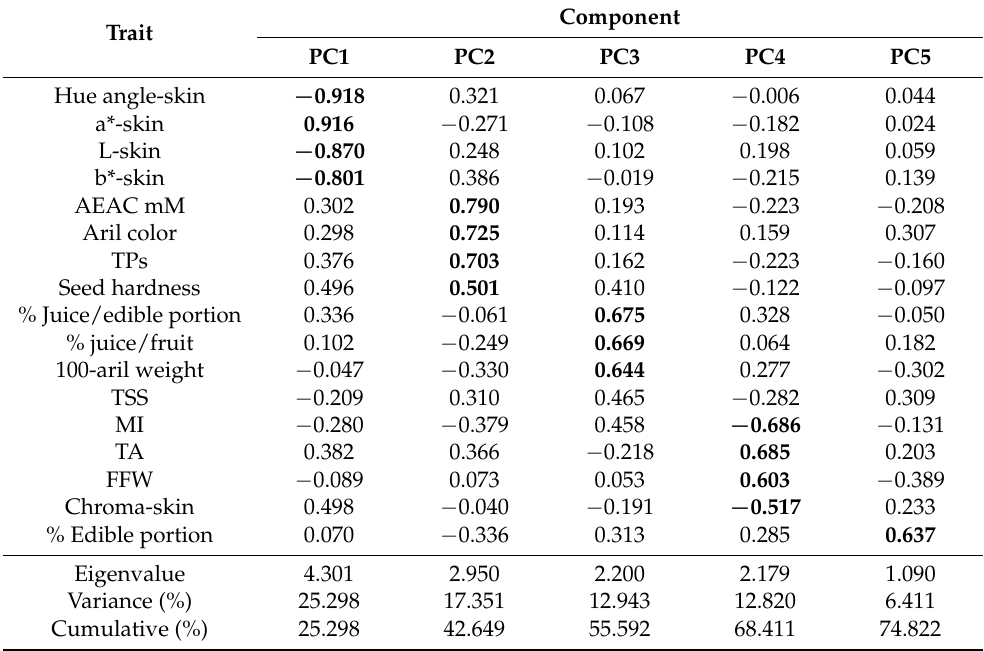
Table 4. Eigenvalues of the five principal component axes from PCA analysis of the studied pomegranate genotypes.